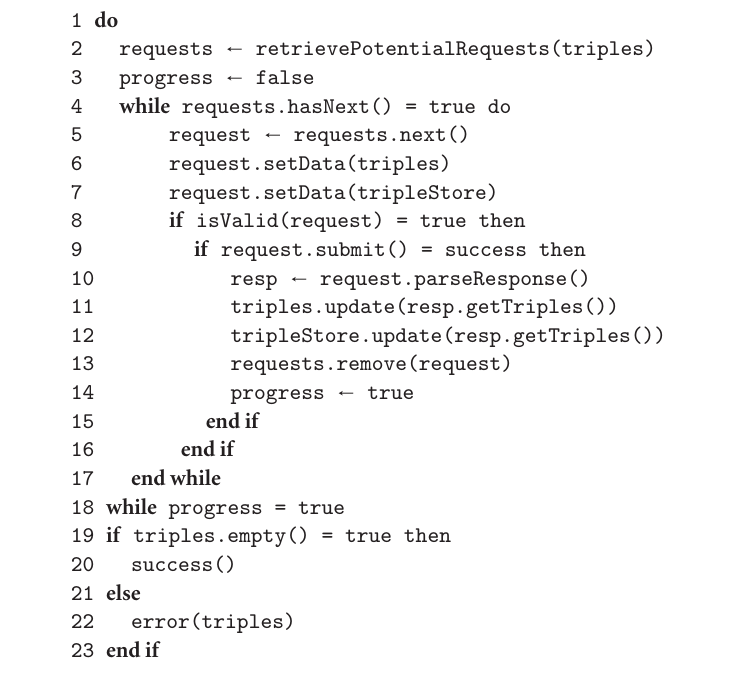
Algorithm 1: SPARQL DATA operations to Web API translation